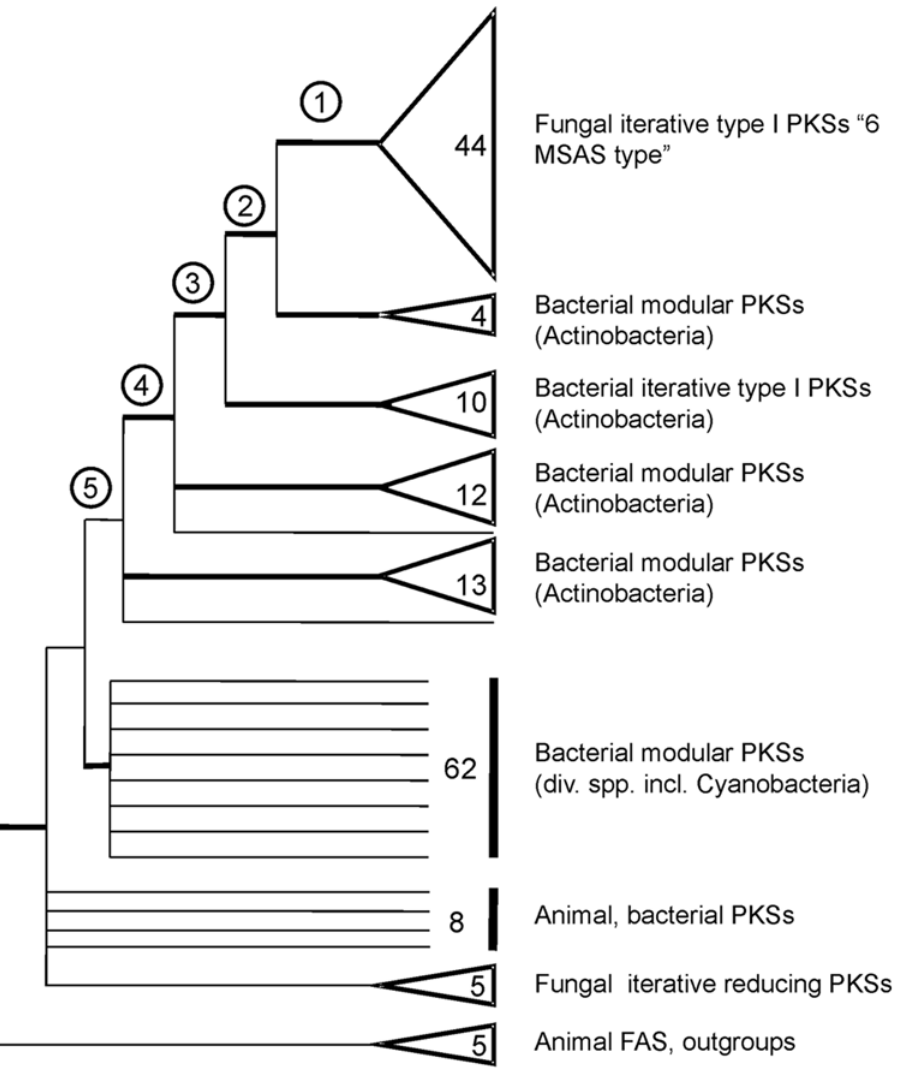
Figure 2. Phylogeny of fungal and bacterial type I PKS genes based on an amino acid alignment of the KS domain (165 sequences). This is a cartoon summary of a 50% majority rule consensus tree of 120,000 trees from a Bayesian analysis. Major clades are collapsed and shown as triangles. Numbers at tips indicate numbers of sequences in the group. Bold branches have significant support (posterior probabilities . 94). We reconstructed ancestral character state at nodes 1–5.